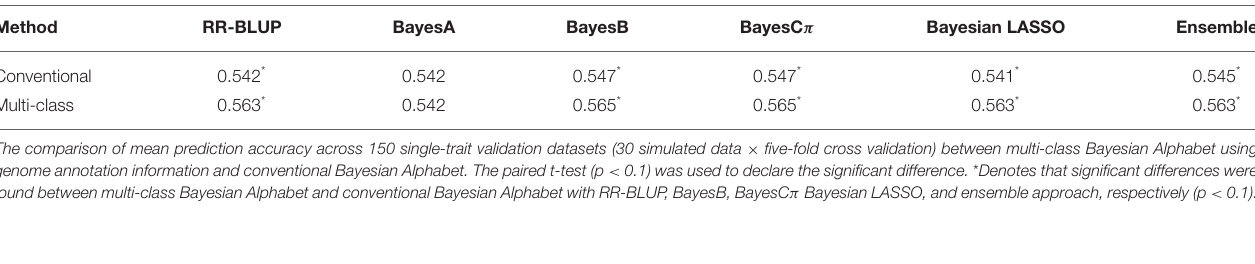
TABLE 2 | Mean prediction accuracy comparison between conventional and multi-class Bayesian Alphabet on multiple-trait simulated data. Method RR-BLUP BayesA BayesB BayesC 5 Bayesian LASSO Ensemble Conventional 0.552 * 0.554 Multi-class